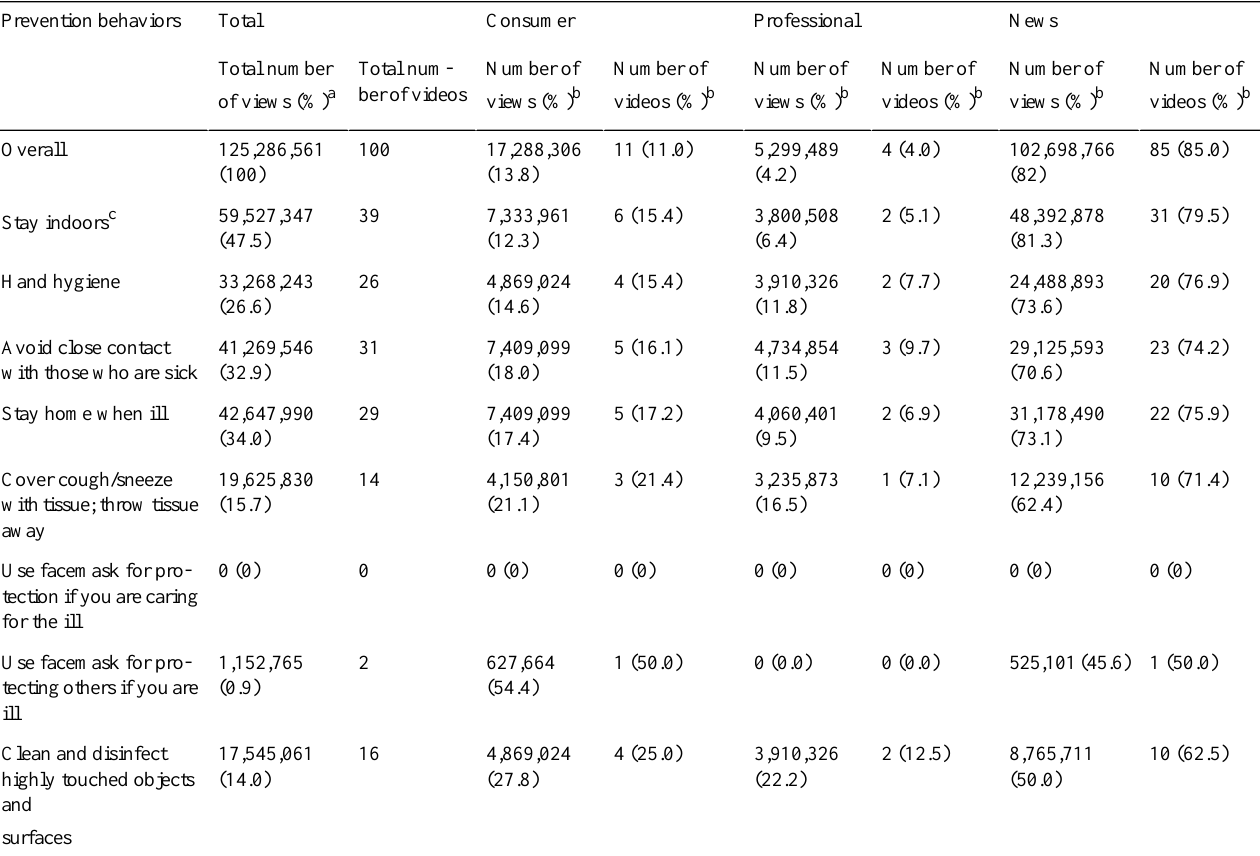
Table 1. Behaviors to mitigate transmission of COVID-19 covered in widely viewed YouTube videos by source in January 2020. NewsProfessionalConsumerTotalPrevention